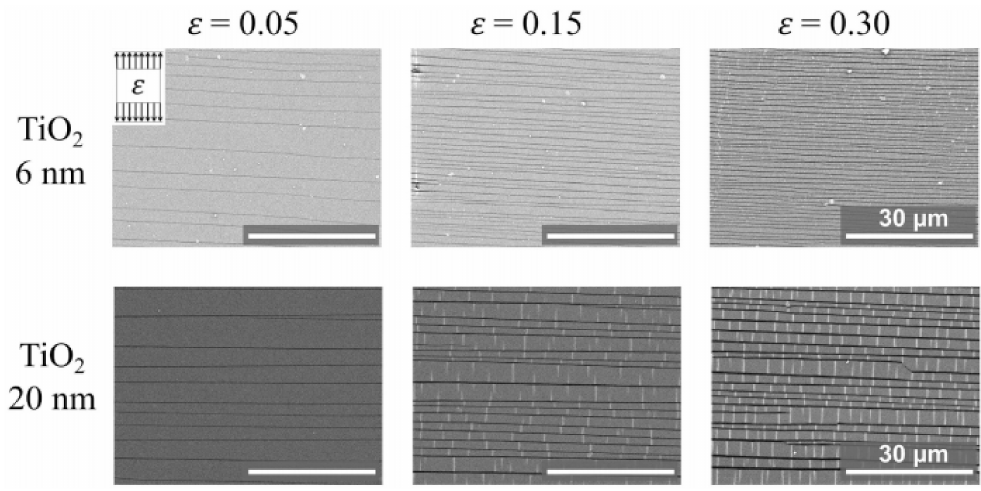
Figure 7. The crack accumulation observed by SEM at 0.05, 0.15, and 0.3 tensile strain for TiO 2 coating [64].